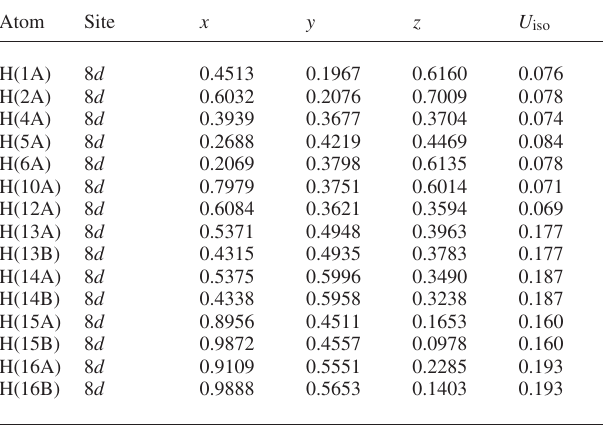
Table 2. Atomic coordinates and displacement parameters (in Å 2 )